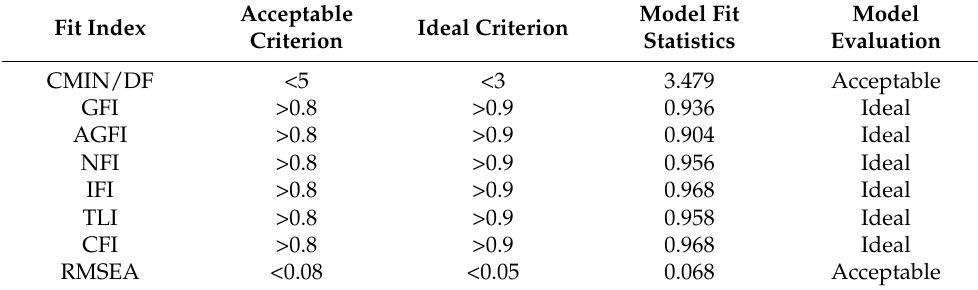
Table A3. CFA fit indices of perceived safety measurement model.